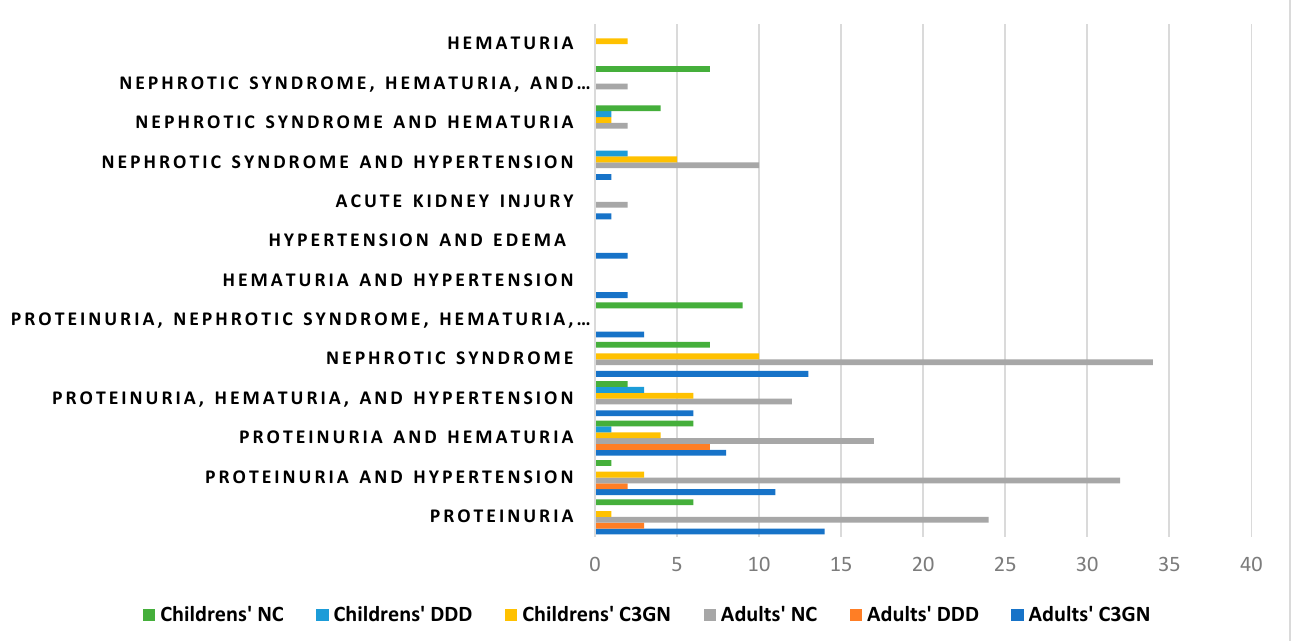
Figure 3. Number of cases in each group diagnosed with a particular symptom or symptoms.